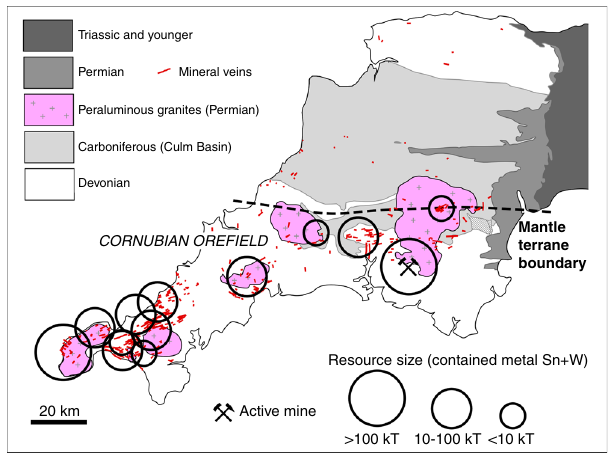
Fig. 6 The distribution of mineral veins in southwest Britain and the location of the giant Cornubian W-Sn ore fi eld. Estimated resource sizes (contained metal Sn and W in kilo-tonnes of reserves and resources) of the main ore districts recognized in the region are indicated by open circles (diameter proportional to resource size), after published data 56 . Also shown is the active world-class Hemerdon W-Sn mine. Mineral veins from 1:50,000 digital data set (DigimapGB-50) from British Geological Survey. Map adapted from regional view geological map from British Geological Survey 59 . © Crown Copyright and Database Right 2018. Ordnance